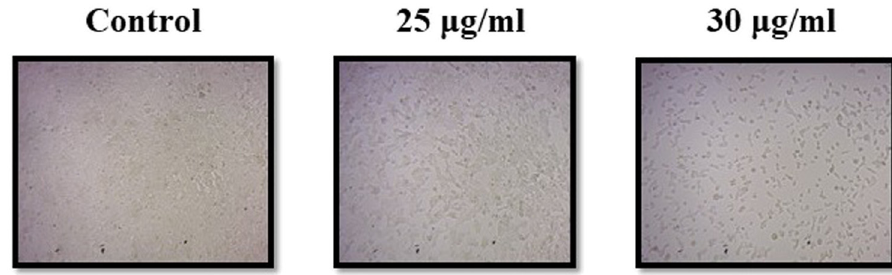
Figure 7: Morphological alterations in HCT - 116 cells treated with CuO NPs for 24 h.